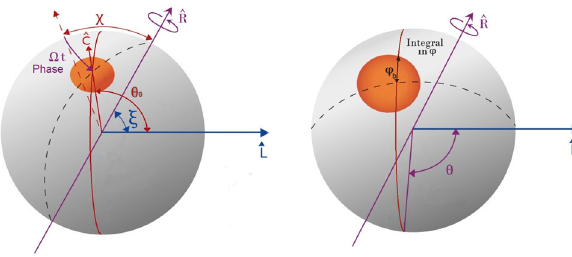
Fig. 5 The figure on the left shows the dependence of the observed position of the cap θ 0 on the phase of the pulsar (cid:2) t . In the figure on the right we see a graphical representation of the φ integral, φ b , at a given